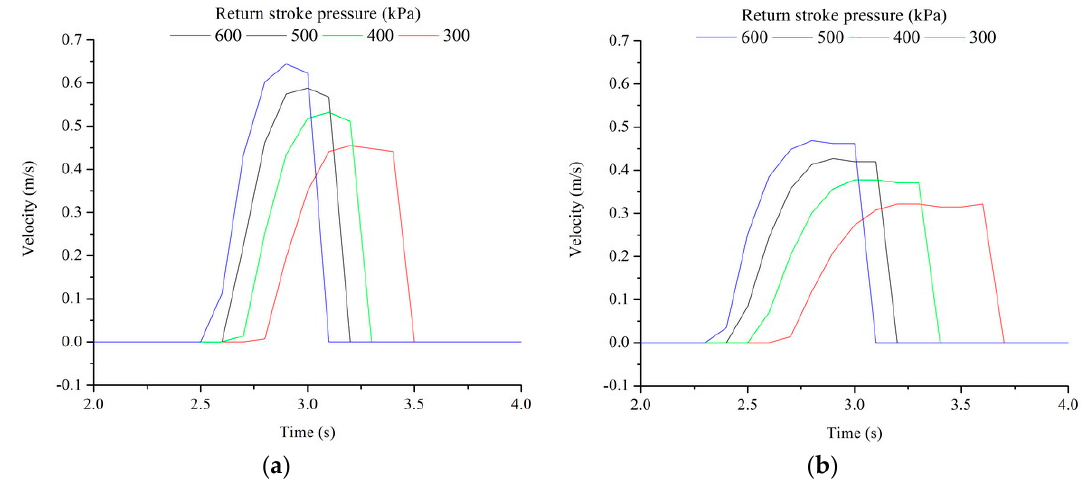
Figure 4. Velocity of cylinder piston movement. Diameter of cylinder: ( a ) 63 mm; ( b ) 80 mm.